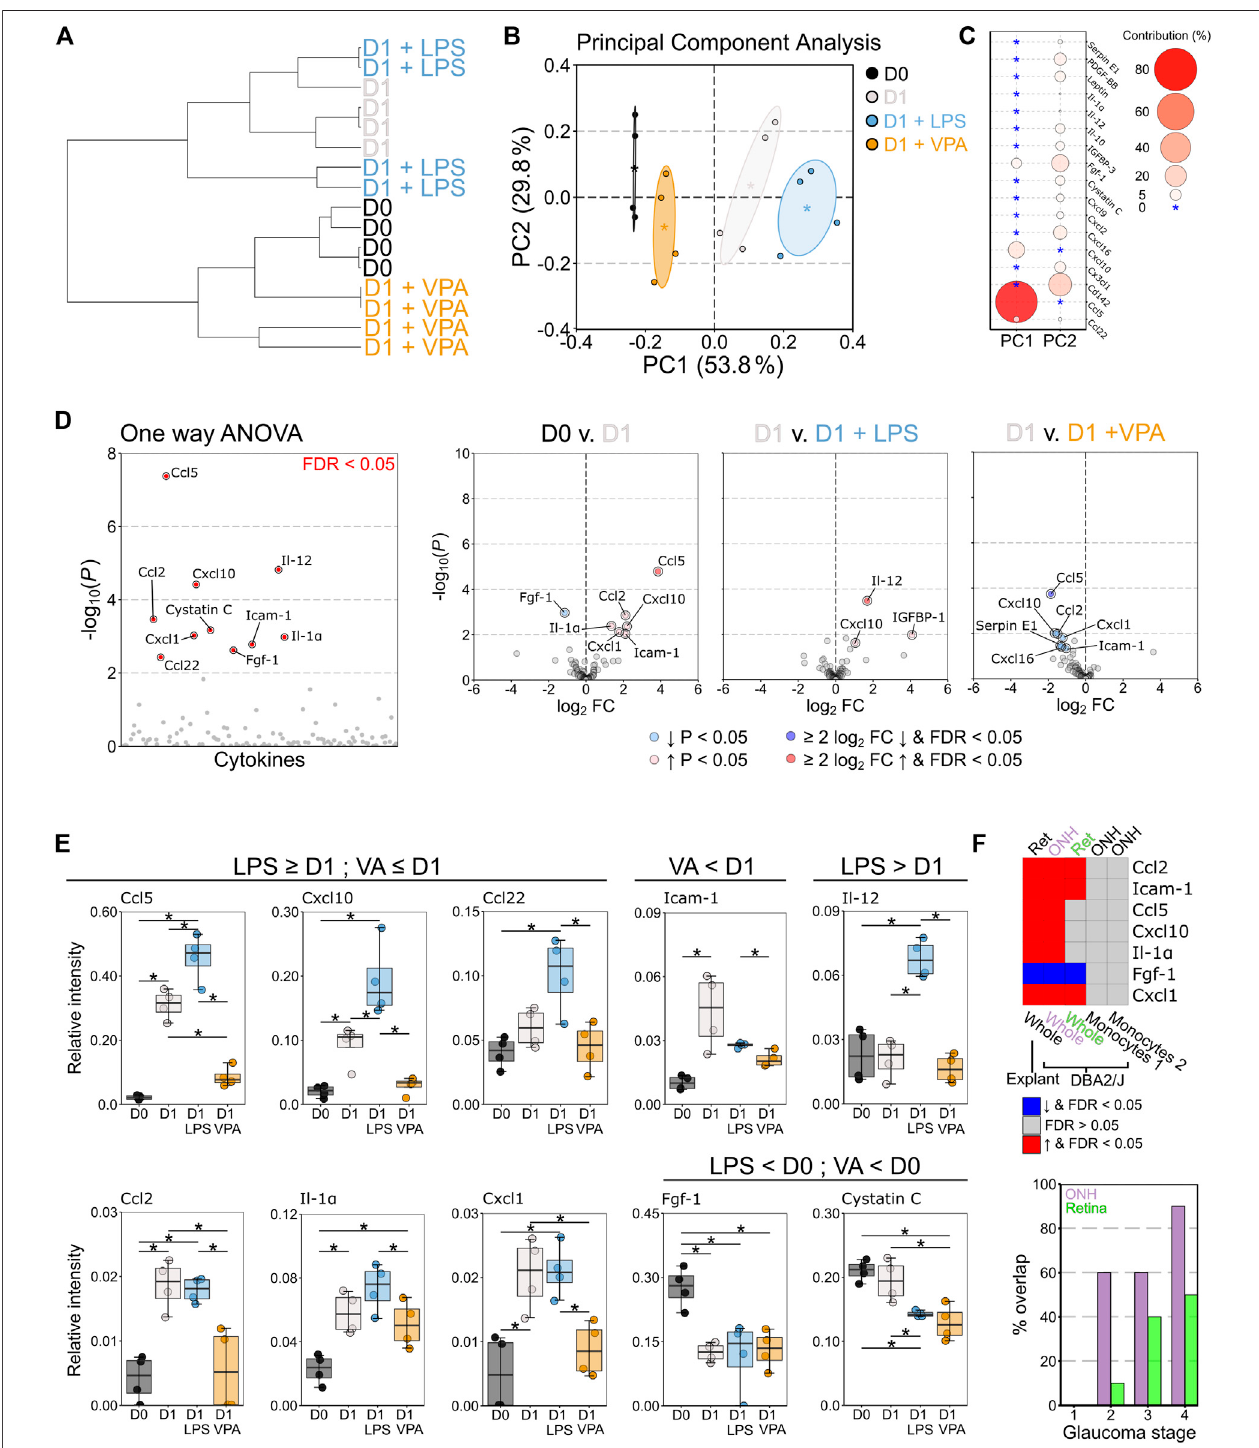
FIGURE 4 | Valproic acid attenuates pro-in fl ammatory cytokine responses from resident glia. Retinal explants were exposed to LPS, VPA, or untreated and assessed at D1 in comparison to D0 controls. Whole retinal homogenates were probed by cytokine array (111 cytokines and chemokines). (A) Hierarchical clustering ( Pearson correlation)demonstratedthatD0andD1retinashaddiscreteglobalcytokinepro fi lesandthatLPStreatedretinasweremostsimilartoD1retinas.VPAtreated retinas clustered with D0, demonstrating a protection against global cytokine changes, and a pro fi le most similar to naïve retina. (B) Principle component (PC) analysisdemonstrated acontinuumofchangefromD0retina,withD1VPAleastaltered,followedbyD1,andD1LPSthemostsigni fi cantlychanged. (C) Thisseparation